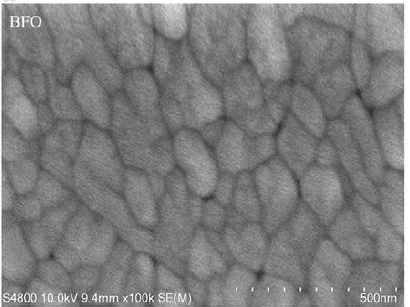
Figure 12. Pure BFO film surface morphology [30].